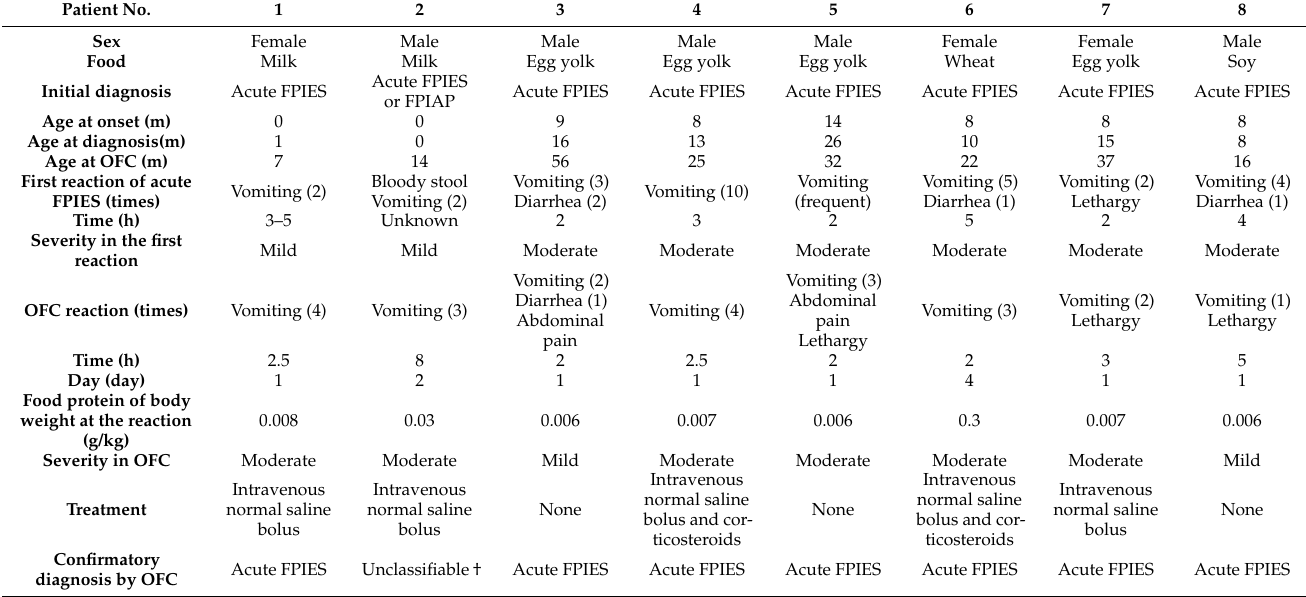
Table 3. Clinical characteristics of subjects who had positive reactions in